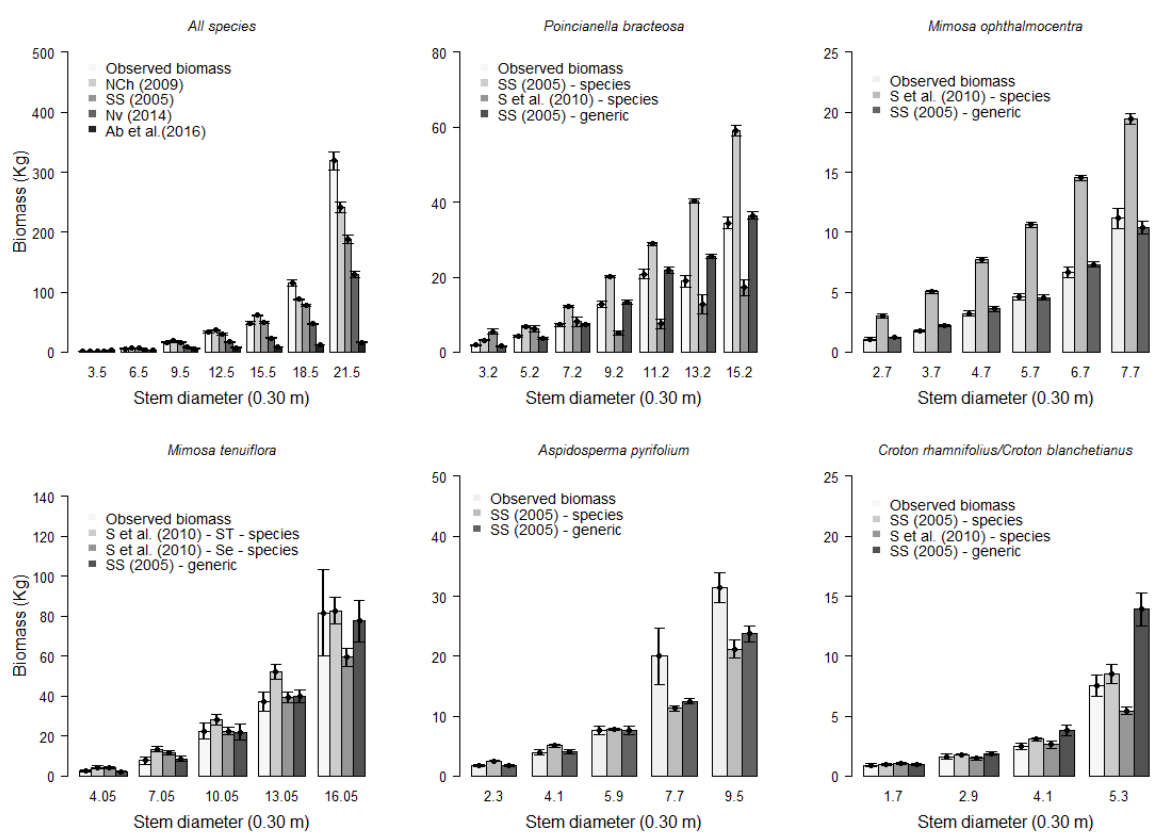
Figure 4 - Comparison of biomass stocks observed and validated by generic and specific equations by diameter class. The bars indicate the confidence interval (mean ± standard error) at 95% of